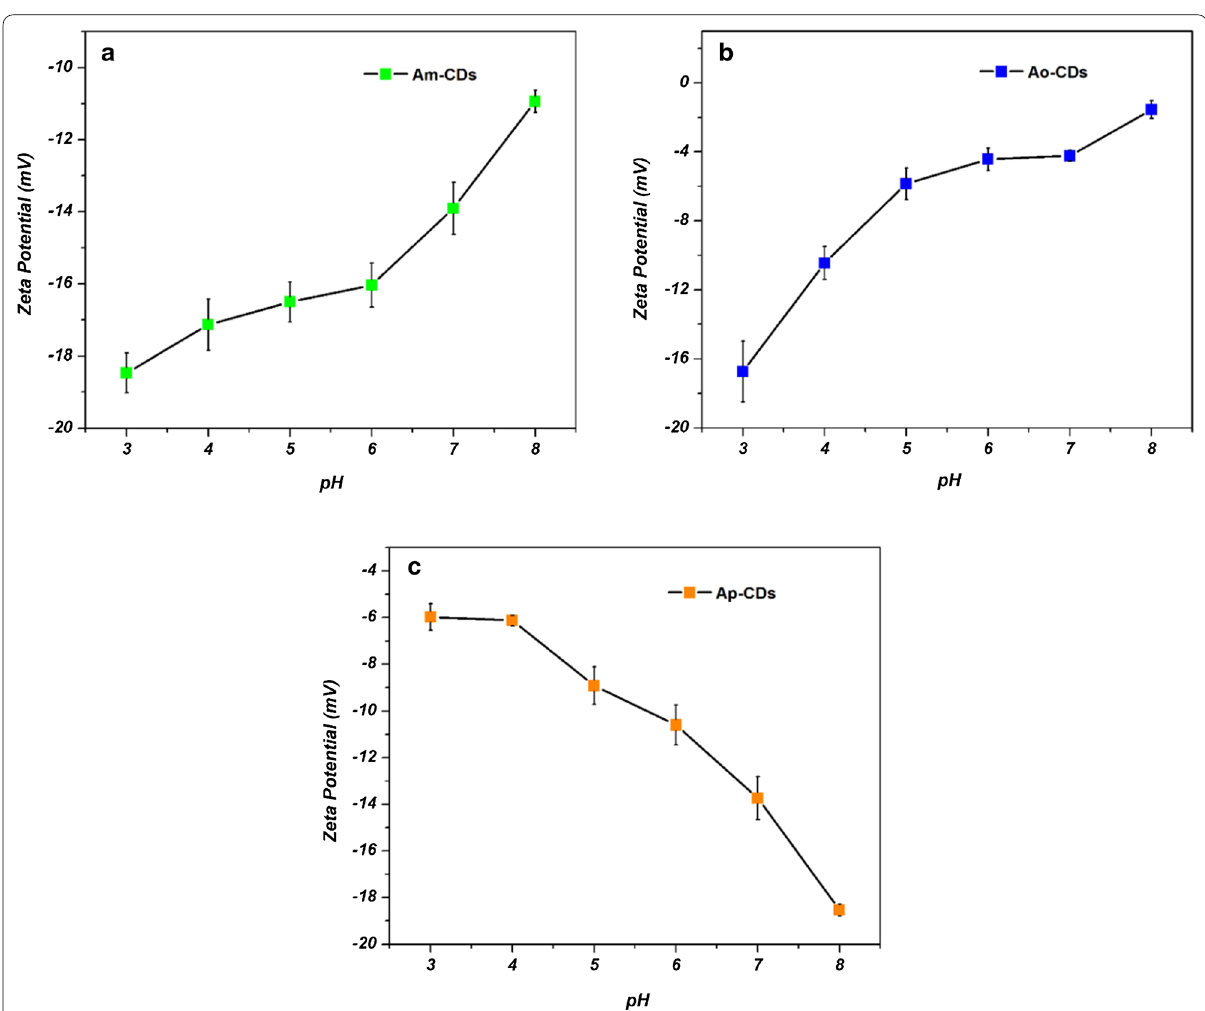
Fig. 9 Zeta potential of a A m -CDs, b A o -CDs, and c A p -CDs under various pH values,